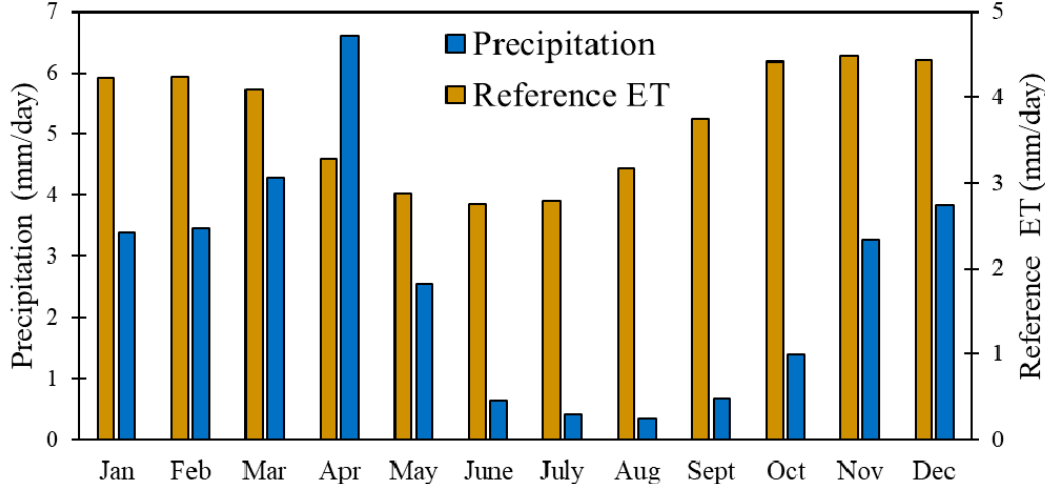
Figure 1. Average daily rainfall and reference ET (1971–2000) for Morogoro, Tanzania.